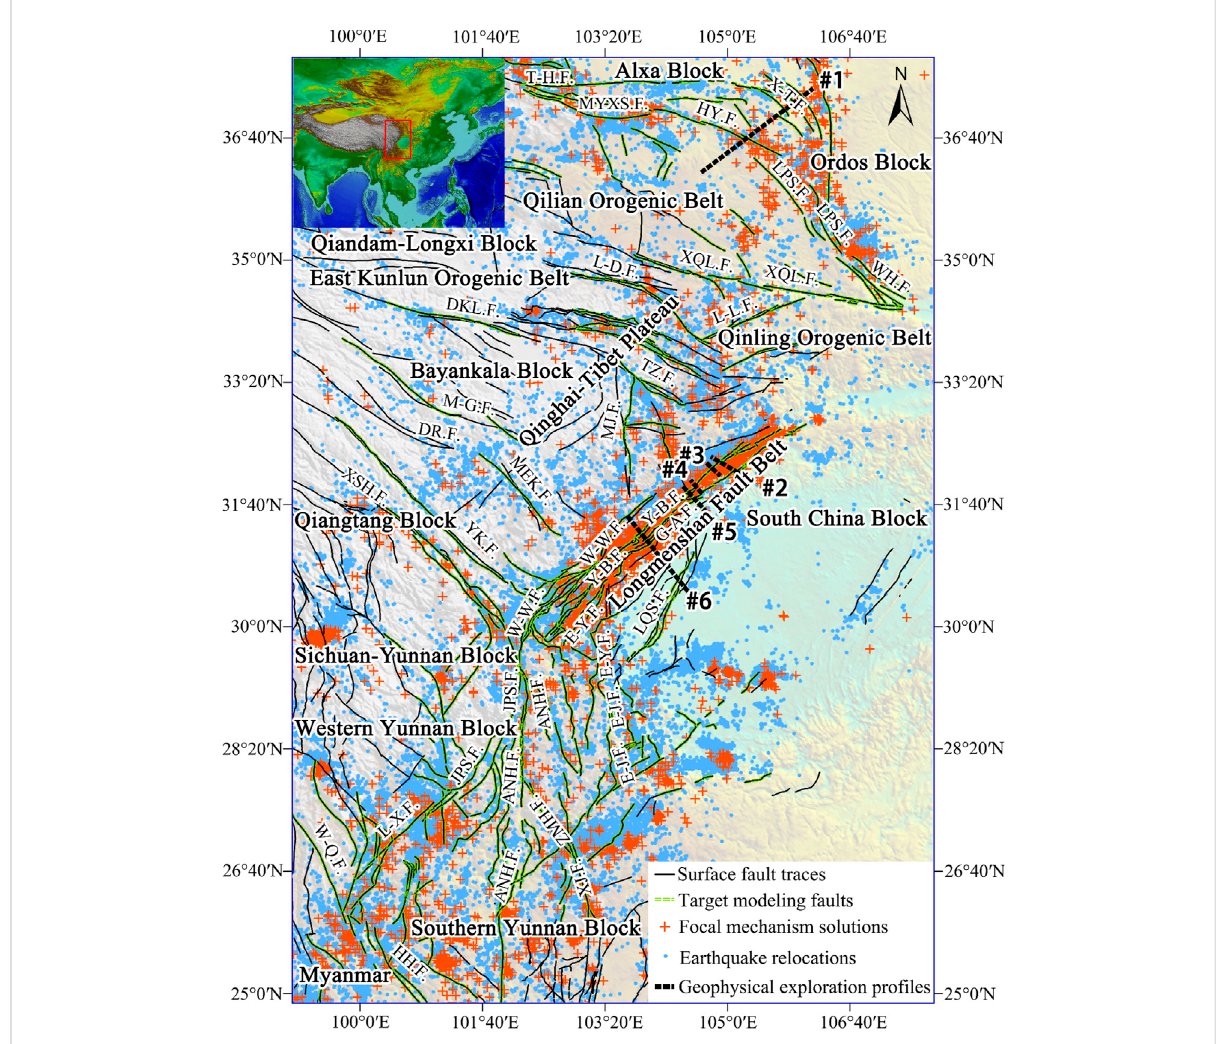
FIGURE 1 Tectonic setting and basic data distribution for fault modeling in the North – South Seismic Belt, China. ETOPO1 (Amante, 2009) is used as the topographic base map. The black solid lines represent the surface fault traces, (Xu et al., 2016), which contain263 faults (segments): Y-B. F., Yingxiu- Beichuan Fault; G-A. F., Guanxian-Anxian Fault; W-W. F., Wenchuan-Wenmao Fault; XSH. F., Xianshuihe Fault; ZMH. F., Zemuhe Fault; ANH. F., AnningheFault;HH.F.,HongheFault;DKL.F.,DongkunlunFault;YK.F.,YukeFault;JPS.F.,JinpingshanFault;L-X.F.,Lijiang-XiaojinheFault;E-J. F., Ebian-Jinyang Fault; XJ. F., Xiaojiang Fault; DR. F., Dari Fault; HY.F., Haiyuan Fault; L-D.F., Lintan-Dangchang Fault; L-L. F., Lixian-Luojiabao Fault; LQS. F., Longquanshan Fault; MEK. F., Malkan Fault; MJ. F., Minjiang Fault; TZ. F., Tazang Fault; XQL. F., Xiqinling Fault. The green dashed lines represent the faults whose subsurface geometries are modeled in this study. The red crosses represent the positions of focal mechanism solutions (Zheng, 2019; Guo et al., 2022). The blue dots represent the relocated epicenters of earthquakes from the Sichuan Earthquake Administration. The black dotted lines represent geophysical exploration pro fi les: #1, an electrical structure pro fi le across the Haiyuan Fault (Min, 2014); #2, a seismic pro fi le across the Yingxiu-Beichuan Fault and Guanxian-Anxian Fault (Dong etal., 2010); #3, a seismic pro fi le across the Yingxiu-Beichuan Fault (Wu et al., 2014); #4, a seismic pro fi le across the Yingxiu-Beichuan Fault (Wu et al., 2014); #5, a seismic pro fi le across the Yingxiu-Beichuan Fault and Guanxian-Anxian Fault (Dong et al., 2010); #6, a seismic pro fi le across the Longquanshan Fault (Dong et al.,